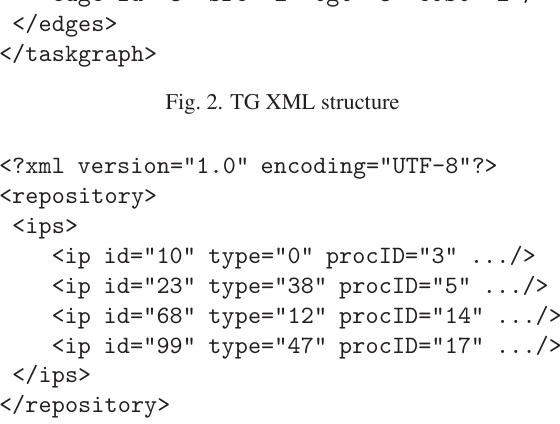
Fig. 3. IP repository XML